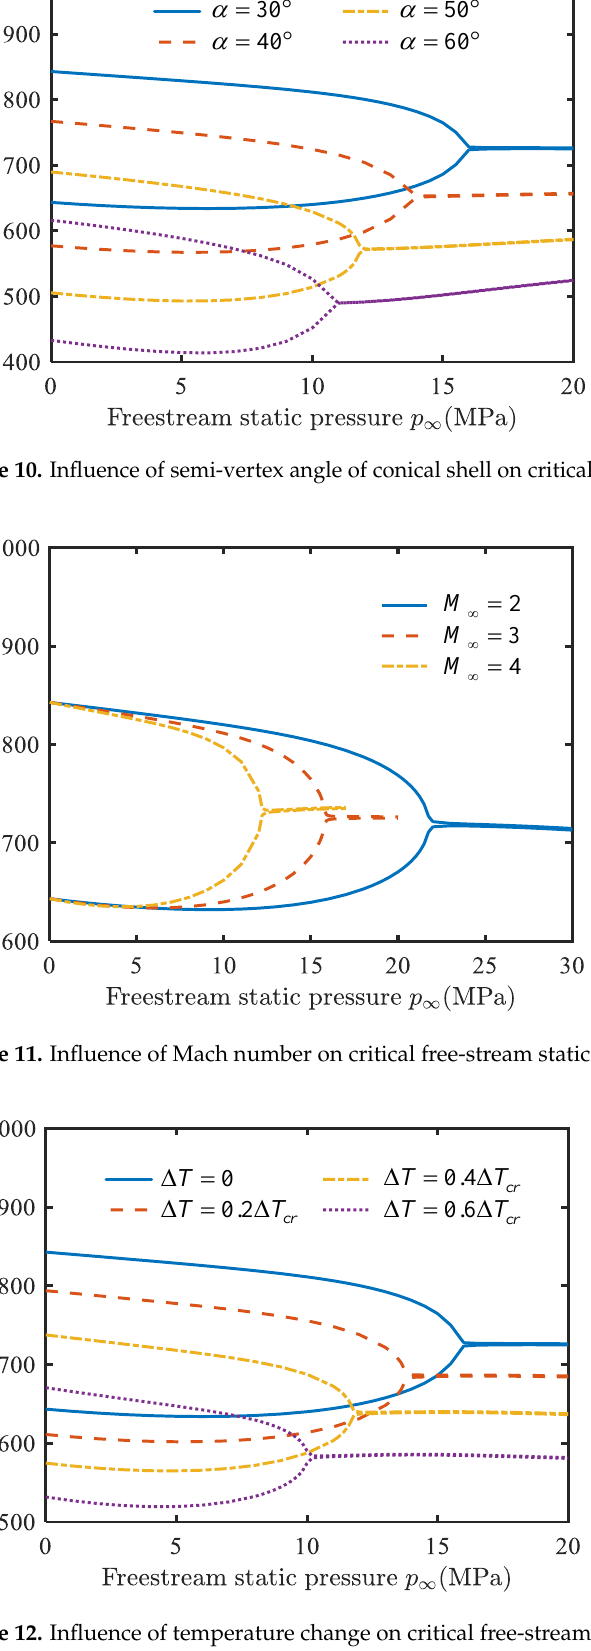
Figure 9. Influence of the thickness-to-radius ratio of the conical shell on critical free-stream static pres- sure ( p = 1).